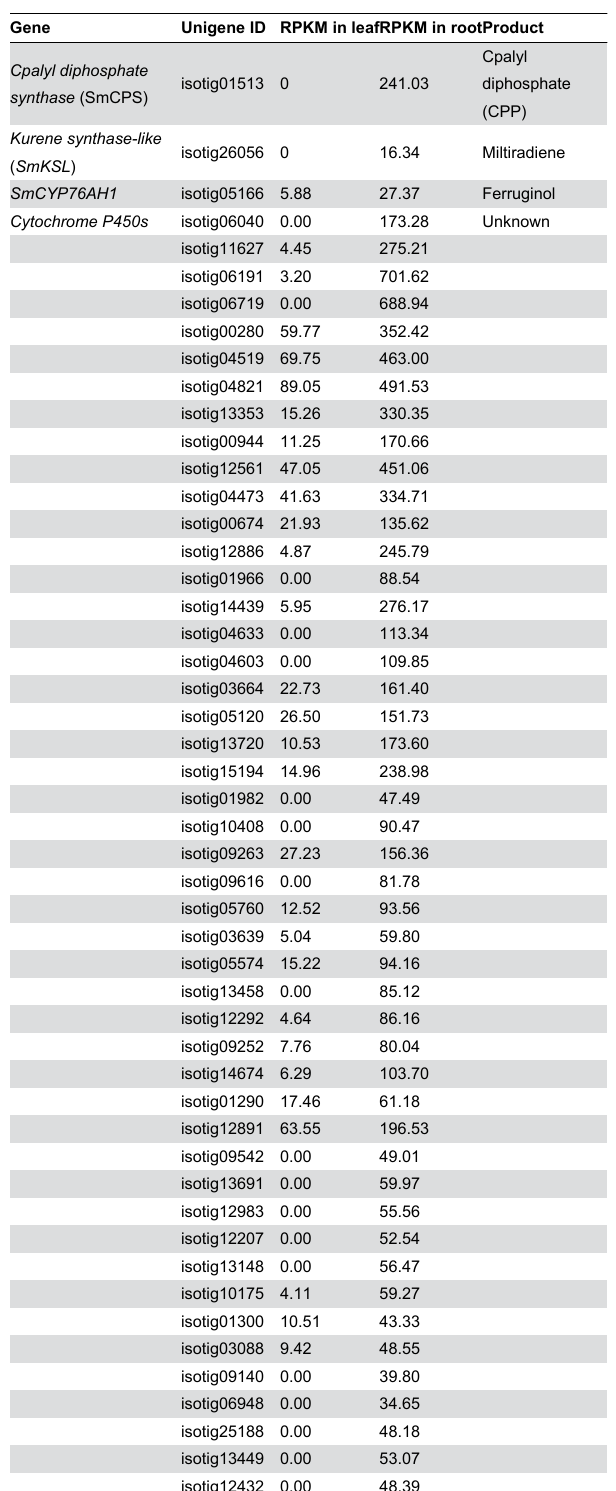
Table 4. Known and candidate genes involved in tanshinones biosynthesis.